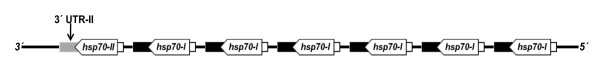
Graphical representation of the 3' UTR-II position in the HSP70 cluster of L. braziliensis.